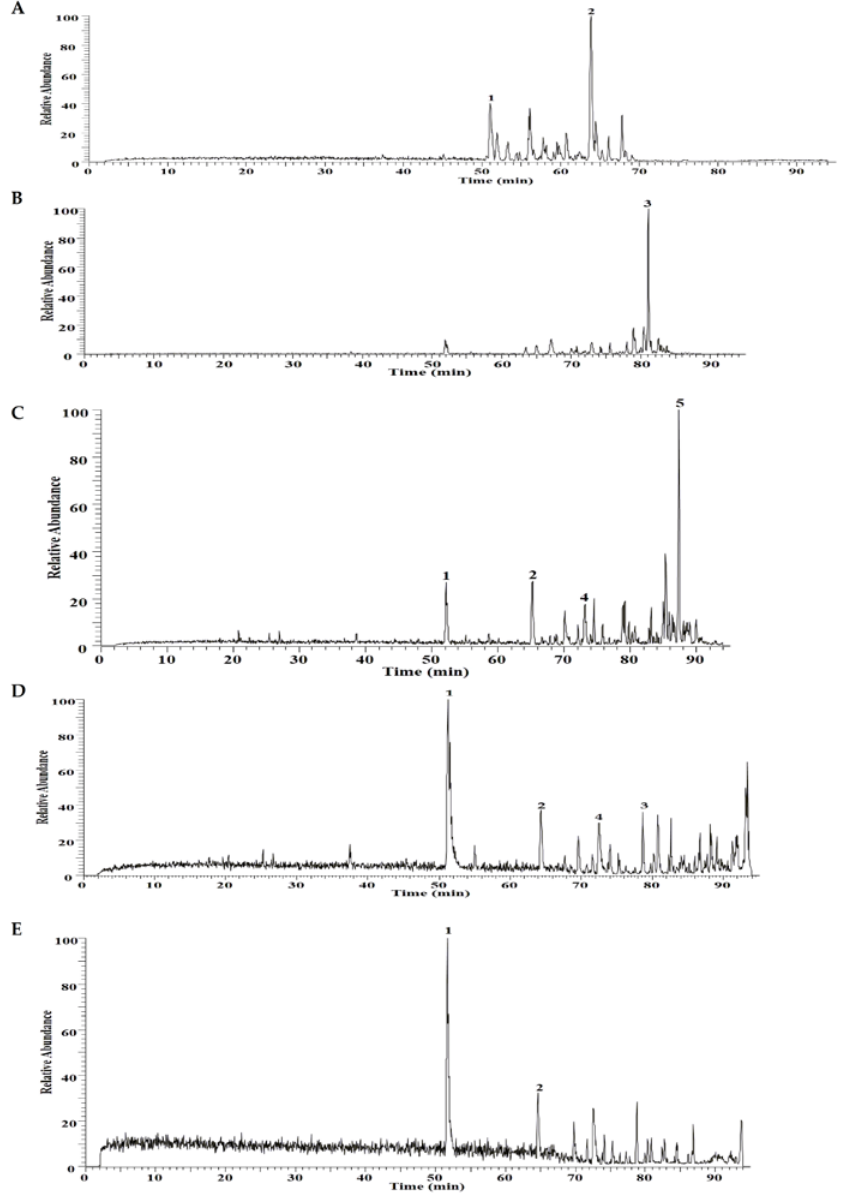
Figure 4. The chromatograms of fractions 14 ( A ); 20 ( B ); 21 ( C ); 22 ( D ); 23 ( E ) from TMYX. Five compounds including glycyrrhizic acid ( 1 ), glycycoumarin ( 2 ), glyasperin A ( 3 ), emodin ( 4 ), licorisoflavan A ( 5 ) were identified, respectively.